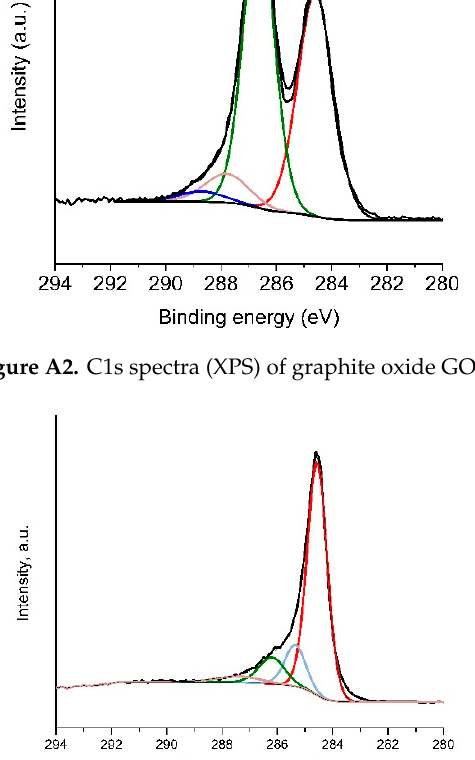
Figure A4. C1s spectra (XPS) of thermally reduced graphene oxide TRGO2.